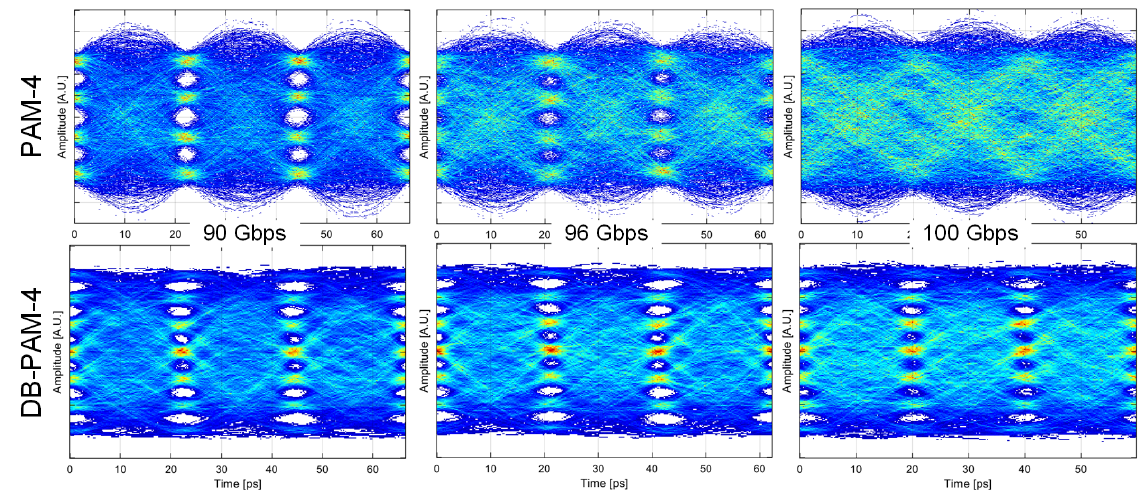
Figure 7. Received electrical eye diagrams for PAM-4 and DB-PAM-4 measured in the high BW system in BtB configuration. The corresponding BER values are graphed in Figure 6b. At 96 Gb/s, both formats share approximately the same BER value and represent the transition